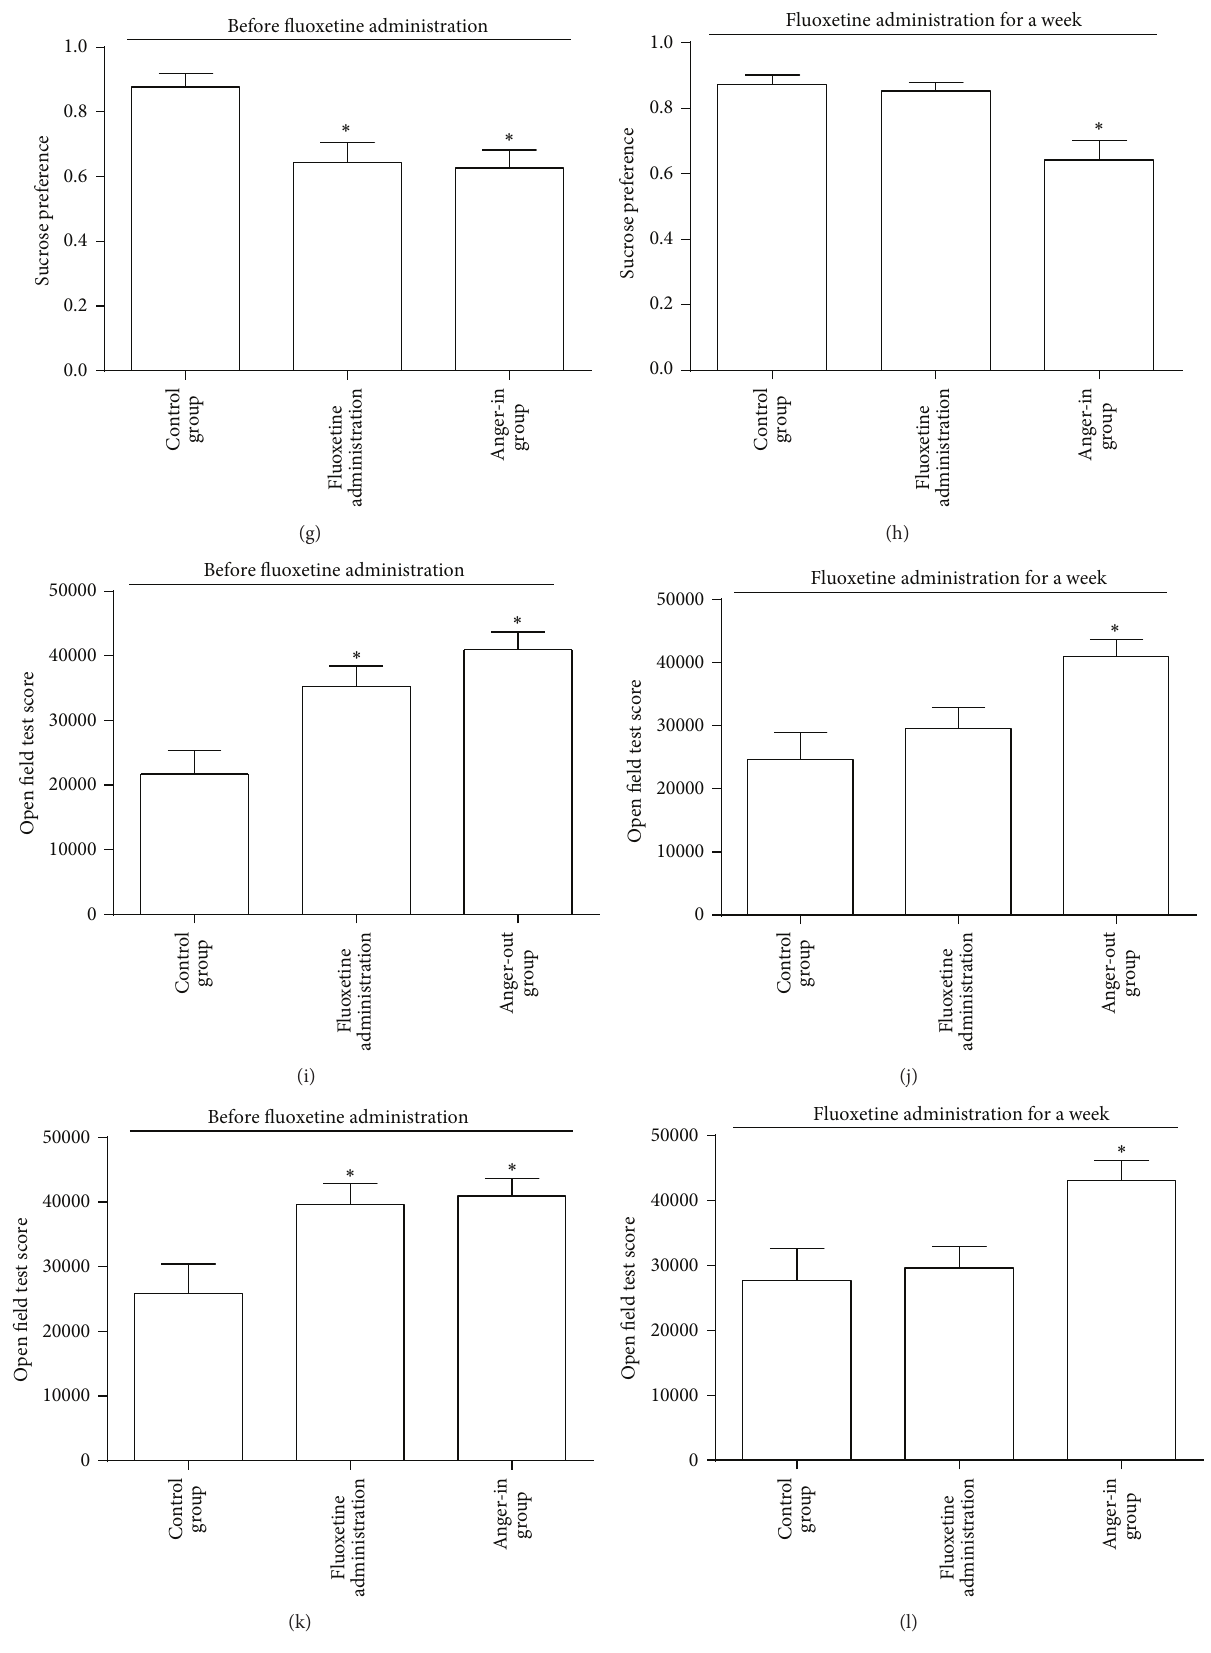
Figure 2: Quantitative analysis ( 𝑛 = 12 ) in weight gain (a, b, c, d), sucrose preference (e, f, g, h), and open field test (i, j, k, l) of anger-out (a, b, e, f, i, j) and anger-in (c, d, g, h, k, l) groups before (a, c, e, g, i, k) and after (b, d, f, h, j, l) fluoxetine administration ( ∗ 𝑃 < 0.05